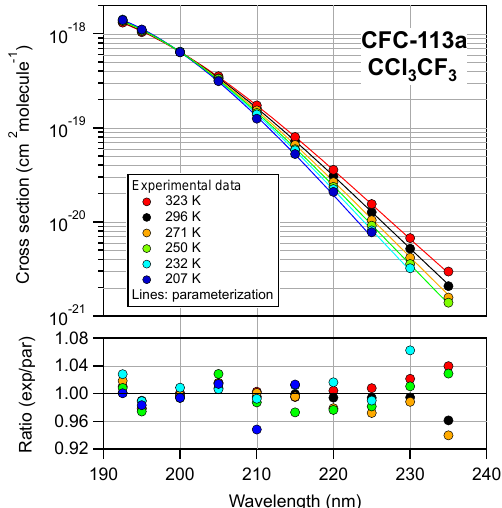
Figure 1. CCl 3 CF 3 (CFC-113a) UV absorption spectrum (base e) and parameterization obtained in this work. Cross section data (symbols, Table 1) and the parameterization of the data using the empirical formula and parameters given in Table 3 (see text). The lower frame shows the overall quality of the